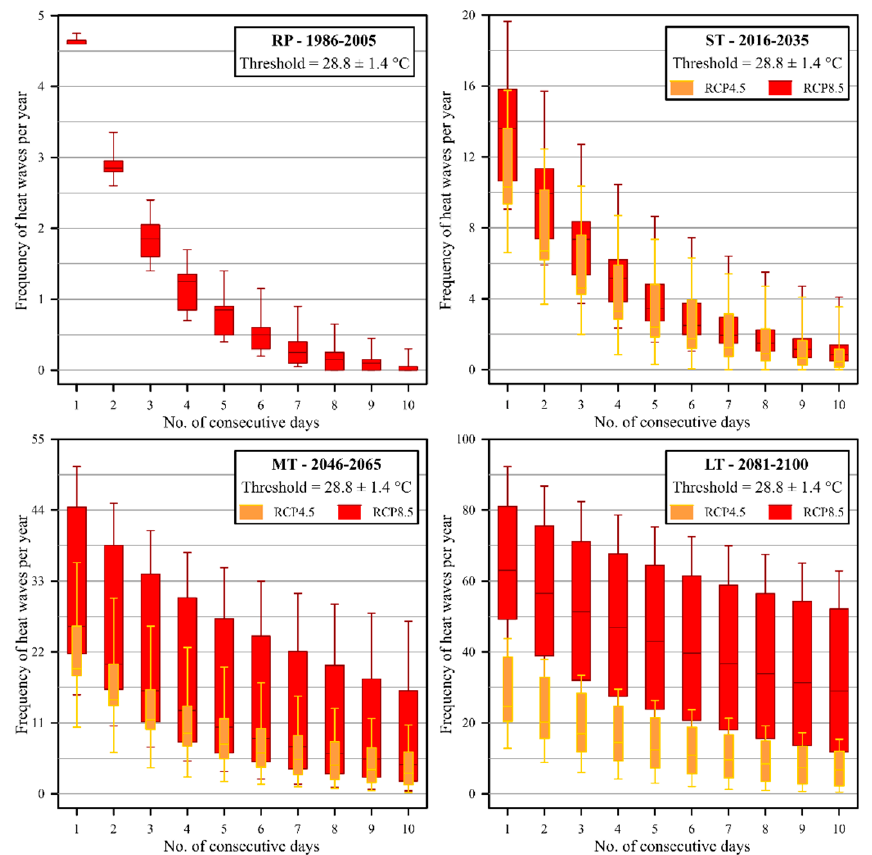
Figure 10. Frequency of the heat waves per year for different values of consecutive days in the reference period (RP) and at the short—(ST), medium—(MT), and long-term (LT), as evaluated by the RCM projections under the RCP4.5 and RCP8.5 scenarios. The box-whisker plots represent the variability between the 13 RCMs (the whiskers indicate the minimum and maximum values). Pay attention to the different vertical scales. Table 6. RCM ensemble mean of the frequency of the heat waves per year for different values of consecutive days in the reference period (RP, 1986–2005) and at the short—(ST,